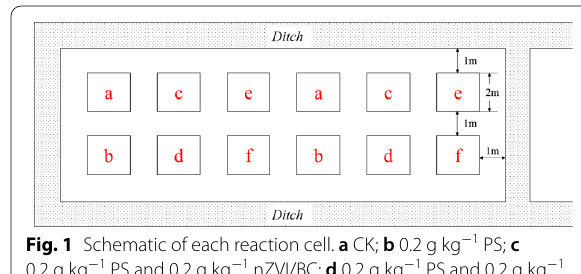
Fig. 1 Schematic of each reaction cell. a CK; b 0.2 g kg − 1 PS; c 0.2 g kg − 1 PS and 0.2 g kg − 1 nZVI/BC; d 0.2 g kg − 1 PS and 0.2 g kg − 1 nZVI/BC; e 0.2 g kg − 1 PS and 0.1 g kg − 1 nZVI; f 0.2 g kg − 1 PS and 0.1 g kg − 1